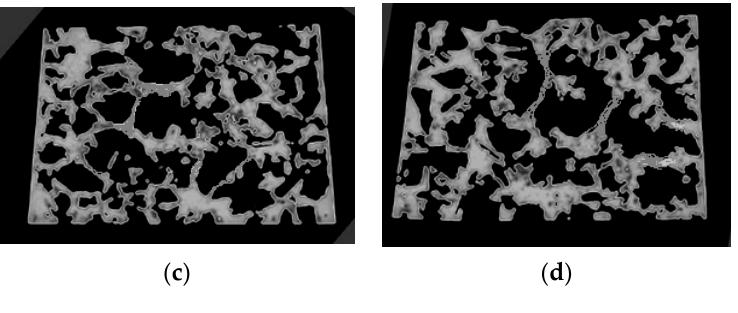
Figure 21. Demonstration of porosity in selected planes of aluminium porous material, AlSi12 sample SAM3, evaluated on a METROTOM 1500 CT ZEISS industrial computed tomograph: diagram of planes of section through porous sample ( a ); cut plane—purple colour ( b ); cut plane—red colour ( c ); cut plane—green colour ( d ).